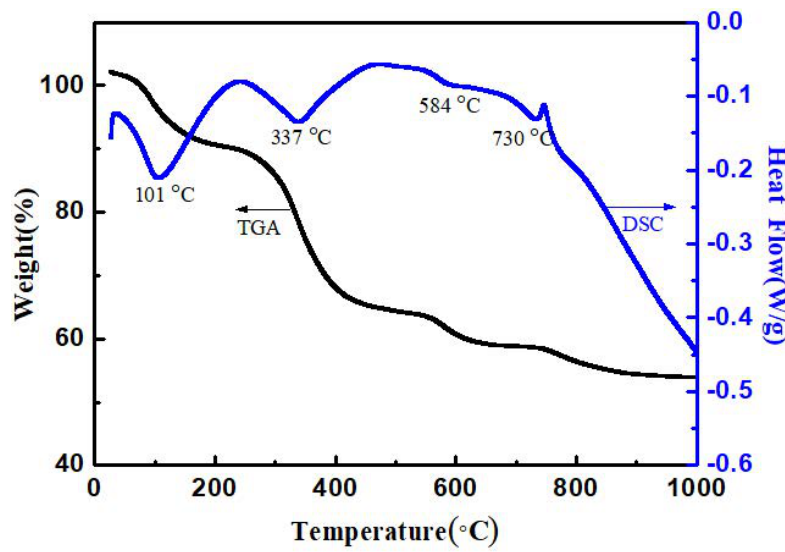
Figure 1. TGA-DSC curves of BST precursors prepared by co-precipitation method.